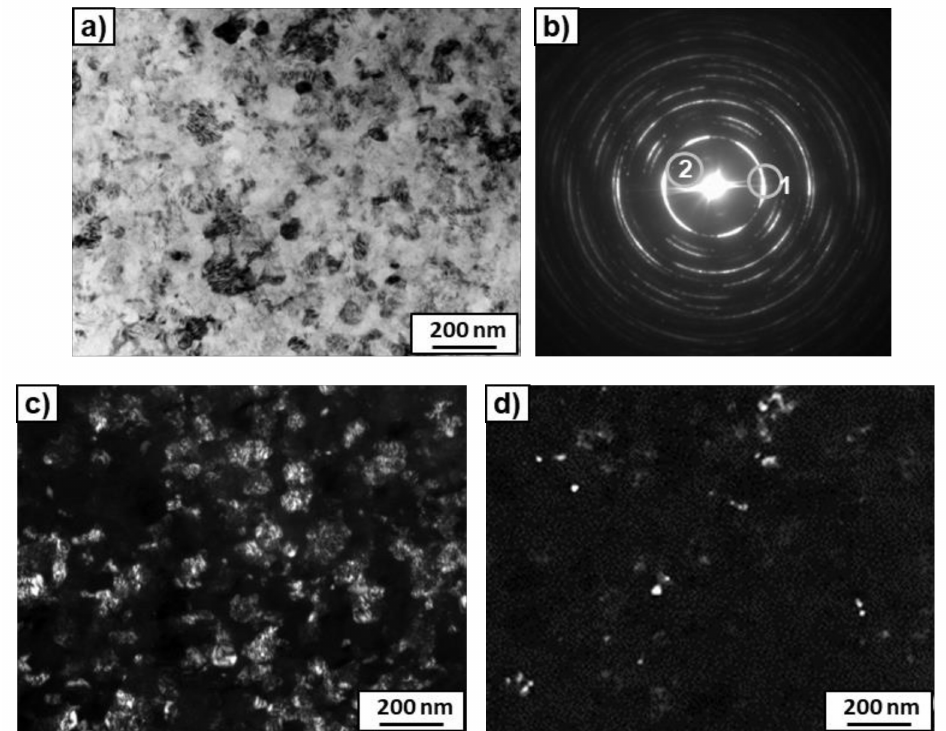
Figure 7. TEM micrographs of the Ti–3wt.% Nb alloy after HPT deformation and pre-annealing at 600 ◦ C. Bright field ( a ), dark field ( c , d ) images and SAED pattern ( b ). The grey rings show the positions of the objective aperture for obtaining the dark-field images (rings 1 and 2 correspond to ( c ) and ( d ) dark field images,